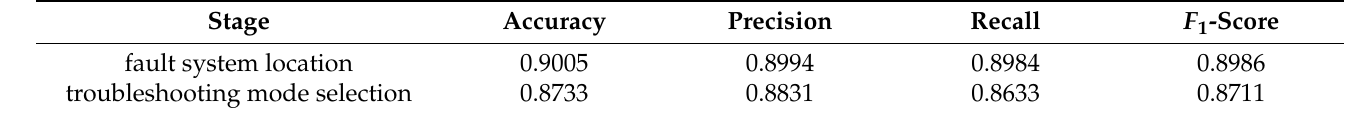
Table 9. The two-stage model effect of troubleshooting mode selection